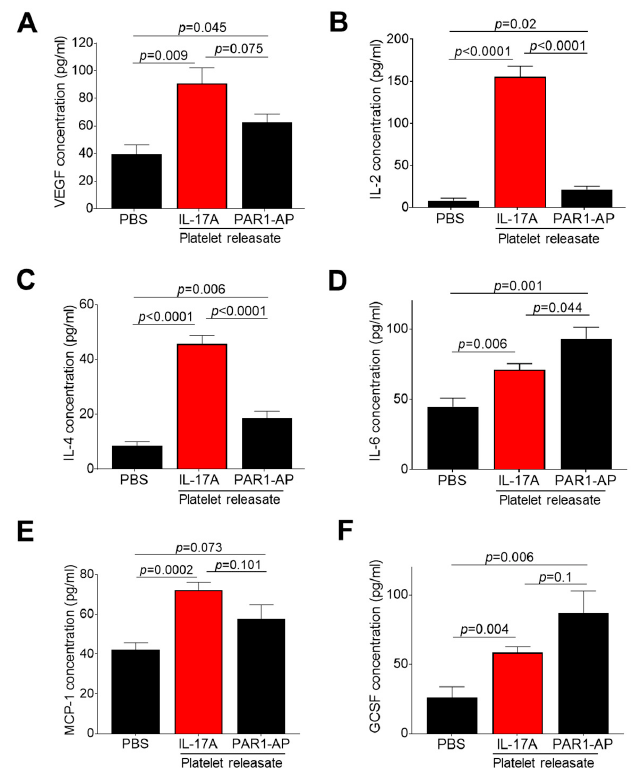
Figure 2. IL-17A/IL-17RA axis mediates the release of several platelet-derived factors with dual function in both inflammation and angiogenesis. Washed platelets were incubated with IL-17A (50 ng/mL) or PAR1-AP (100 μΜ ) or PBS (resting platelets) for 10 min at 37 °C. Using ELISA, the recovered releasates were then analysed for ( A ) vascular endothelial growth factor (VEGF), ( B ) interleukin-2 (IL-2), ( C ) interleukin-4 (IL-4), ( D ) interleukin-6 (IL-6), ( E ) monocyte chemoattractant protein-1 (MCP-1) and ( F ) granulocyte colony-stimulating factor (GCSF). Values are presented as the mean concentration (pg/mL) ± SEM of six independent experiments. With regard to statistics, p -value of two-tailed t test is reported per indicated pairwise comparison as normality test was passed. Adjusted p -value for IL-17A-treated releasate protein levels (vs. PBS-treatment) is p < 0.05 for all as determined by one-way ANOVA followed by Dunnett’s multiple comparison test. No statistical significance is denoted as